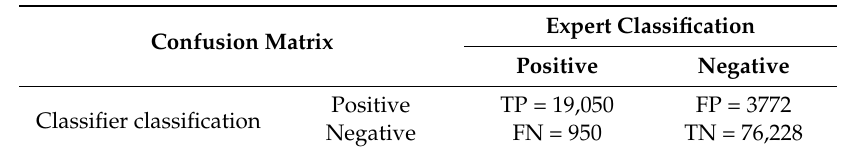
Table 4. Confusion matrix obtained in the detection of cracks in tunnels using the Gabor filters invariant to rotation.